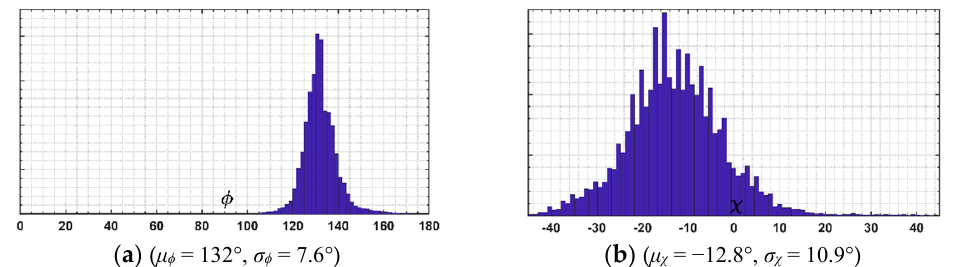
Figure 10. Histograms of the most robust polarizations, extracted from the second cavity: ( a ) Orientation angle and ( b )